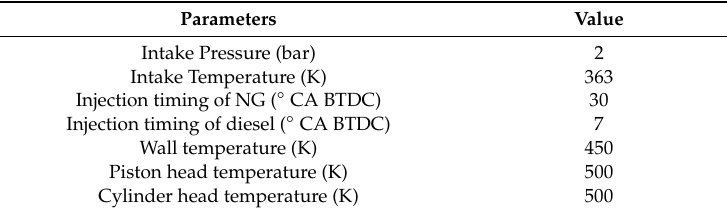
Table 4. Model verification of main boundary conditions at working points.